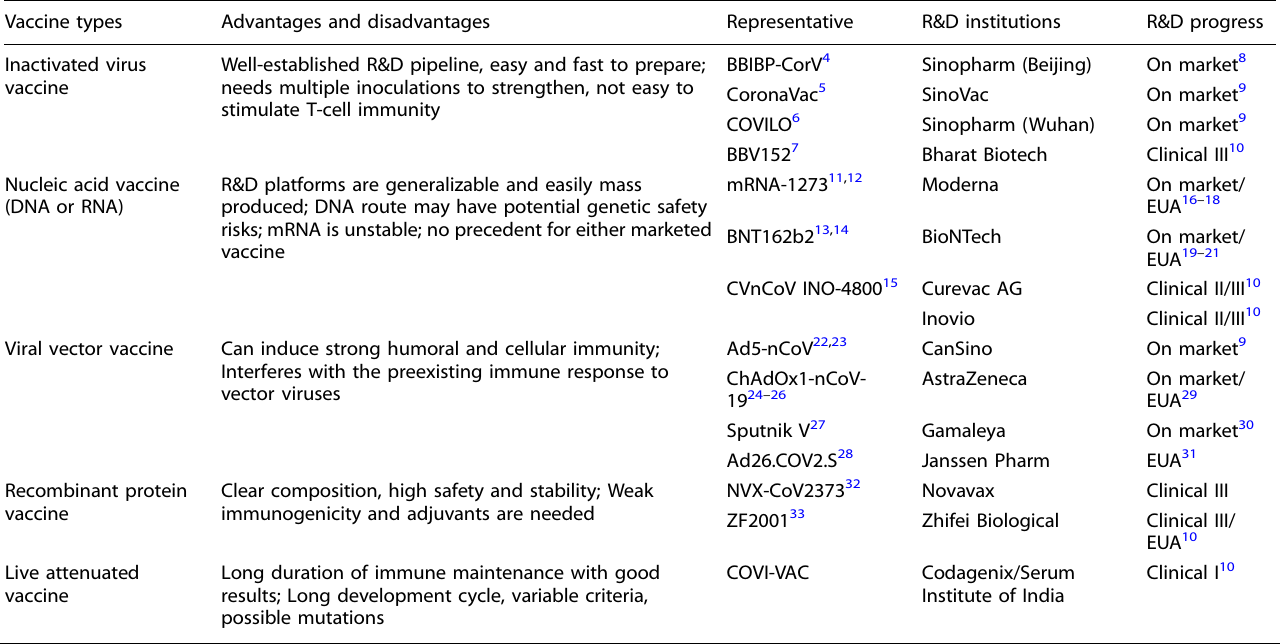
Table 1. Progress of representative COVID-19 vaccines developed by different